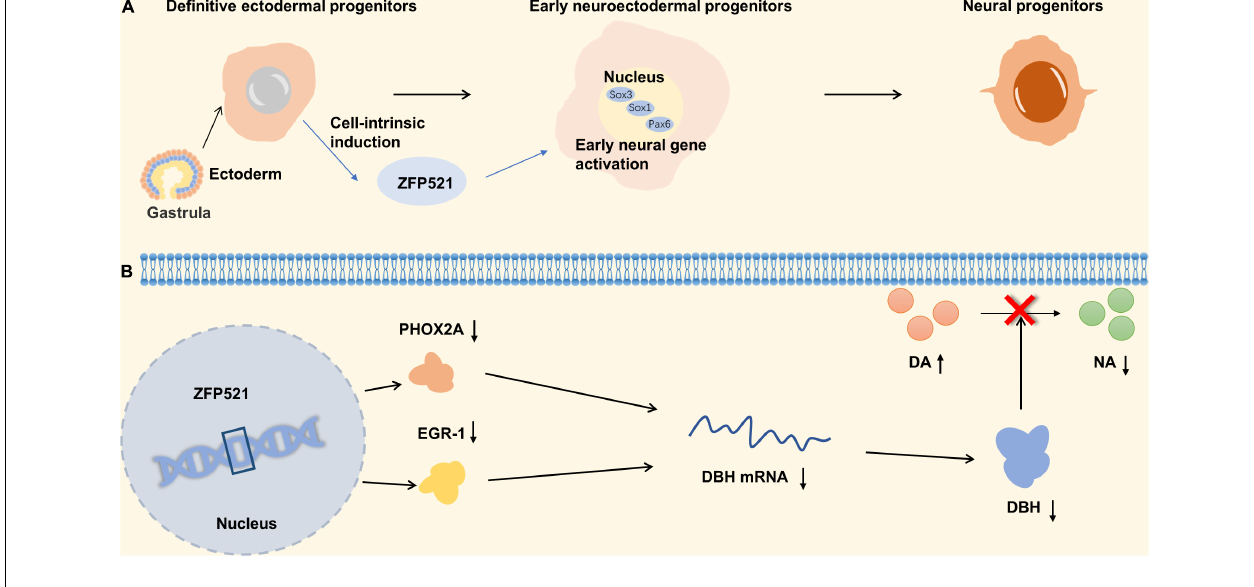
Frontiers in Neuroscience |